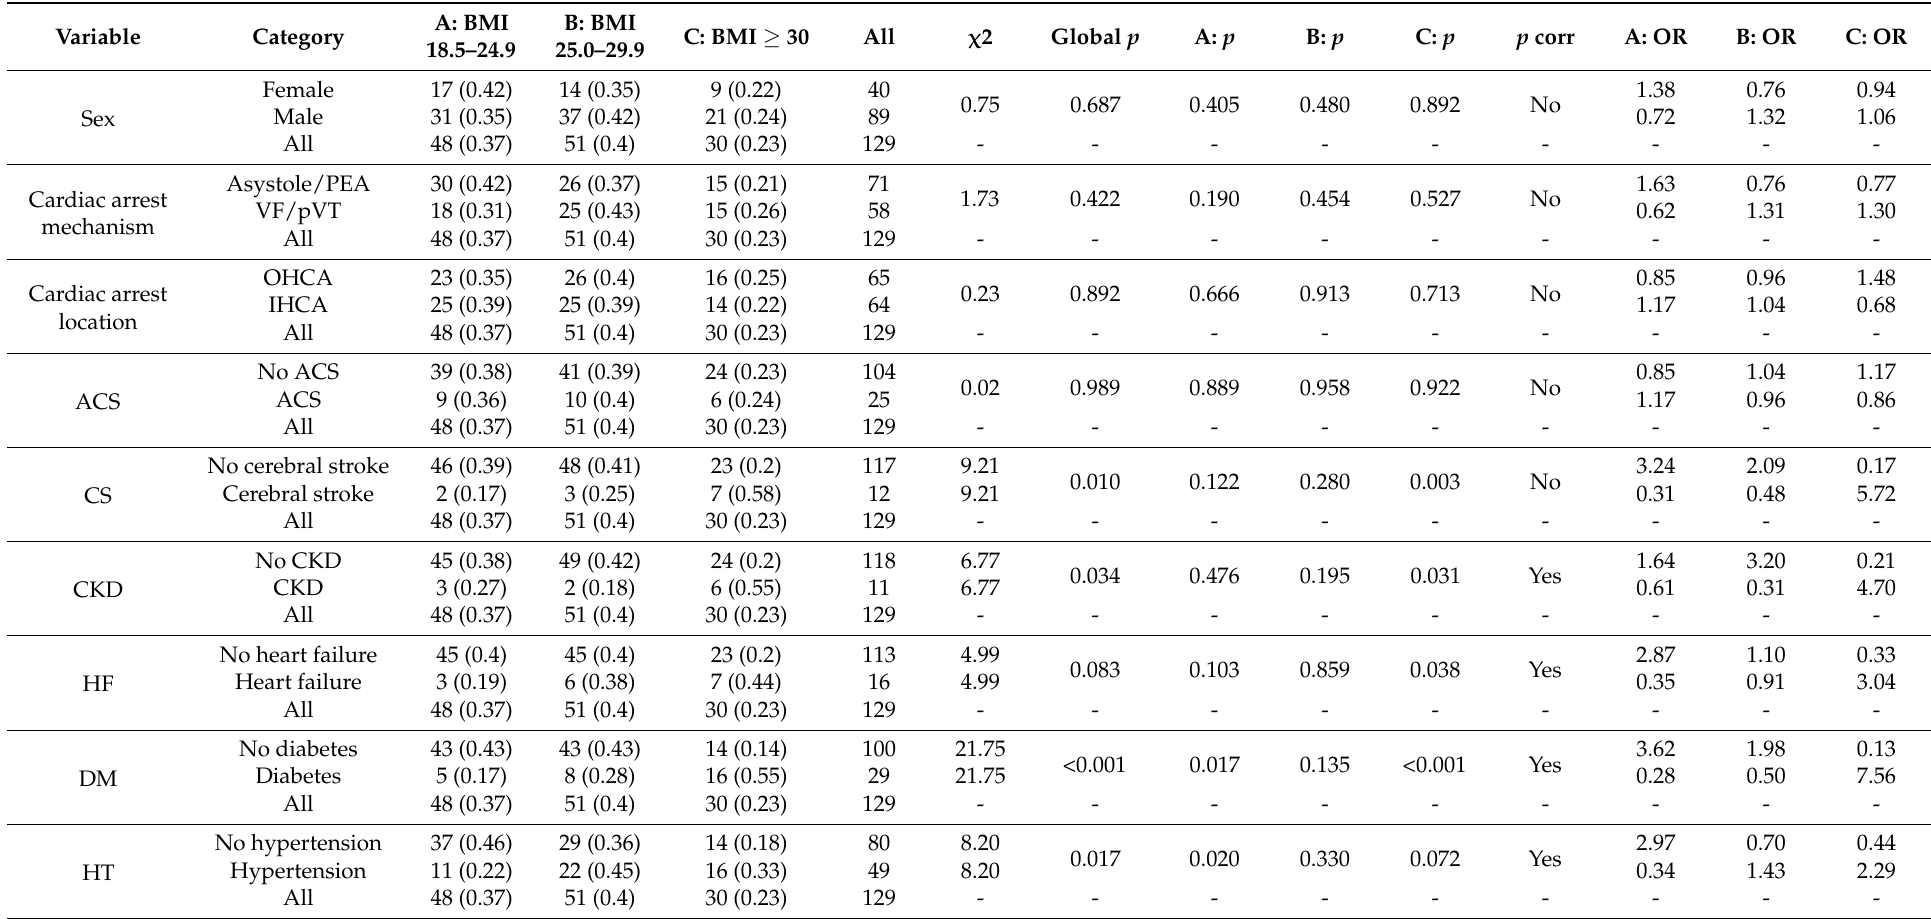
Table 3. The comparison of assessed parameters (categorical variables) with the ranges of BMI (WHO criteria)